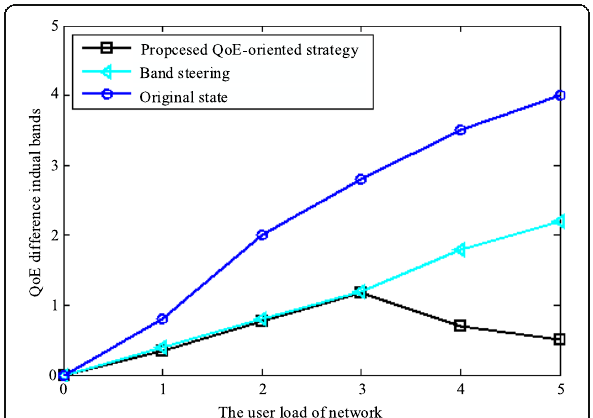
Fig. 8 QoE difference between 2.4 GHz and 5 GHz